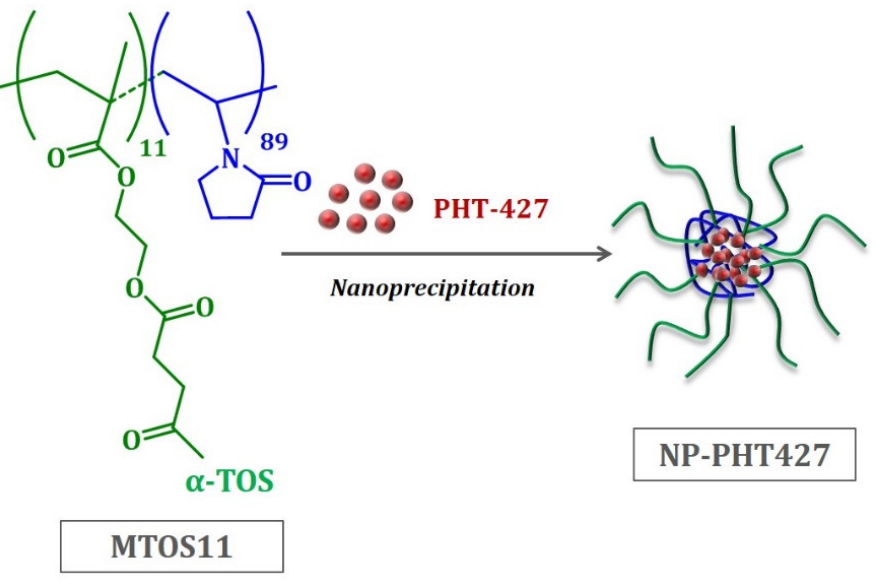
Figure 1. Representative scheme of the formation and the structure of NP-PHT427.